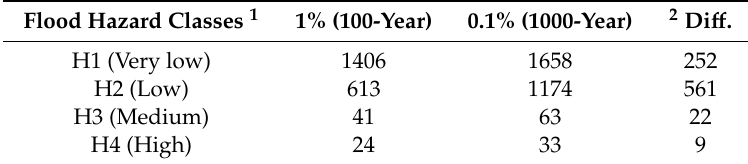
Table 4. Number of potentially a ff ected buildings by floods vs. flood hazard classes computed for each